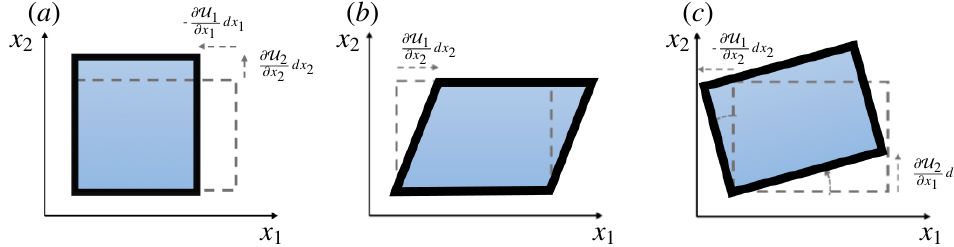
Figure 3. Two-dimensional sketch of the fluid motion deformation due to ( a ) normal-strain-rate tensor, ( b ) shear tensor, and ( c ) rigid-body-rotation tensor. Adapted from